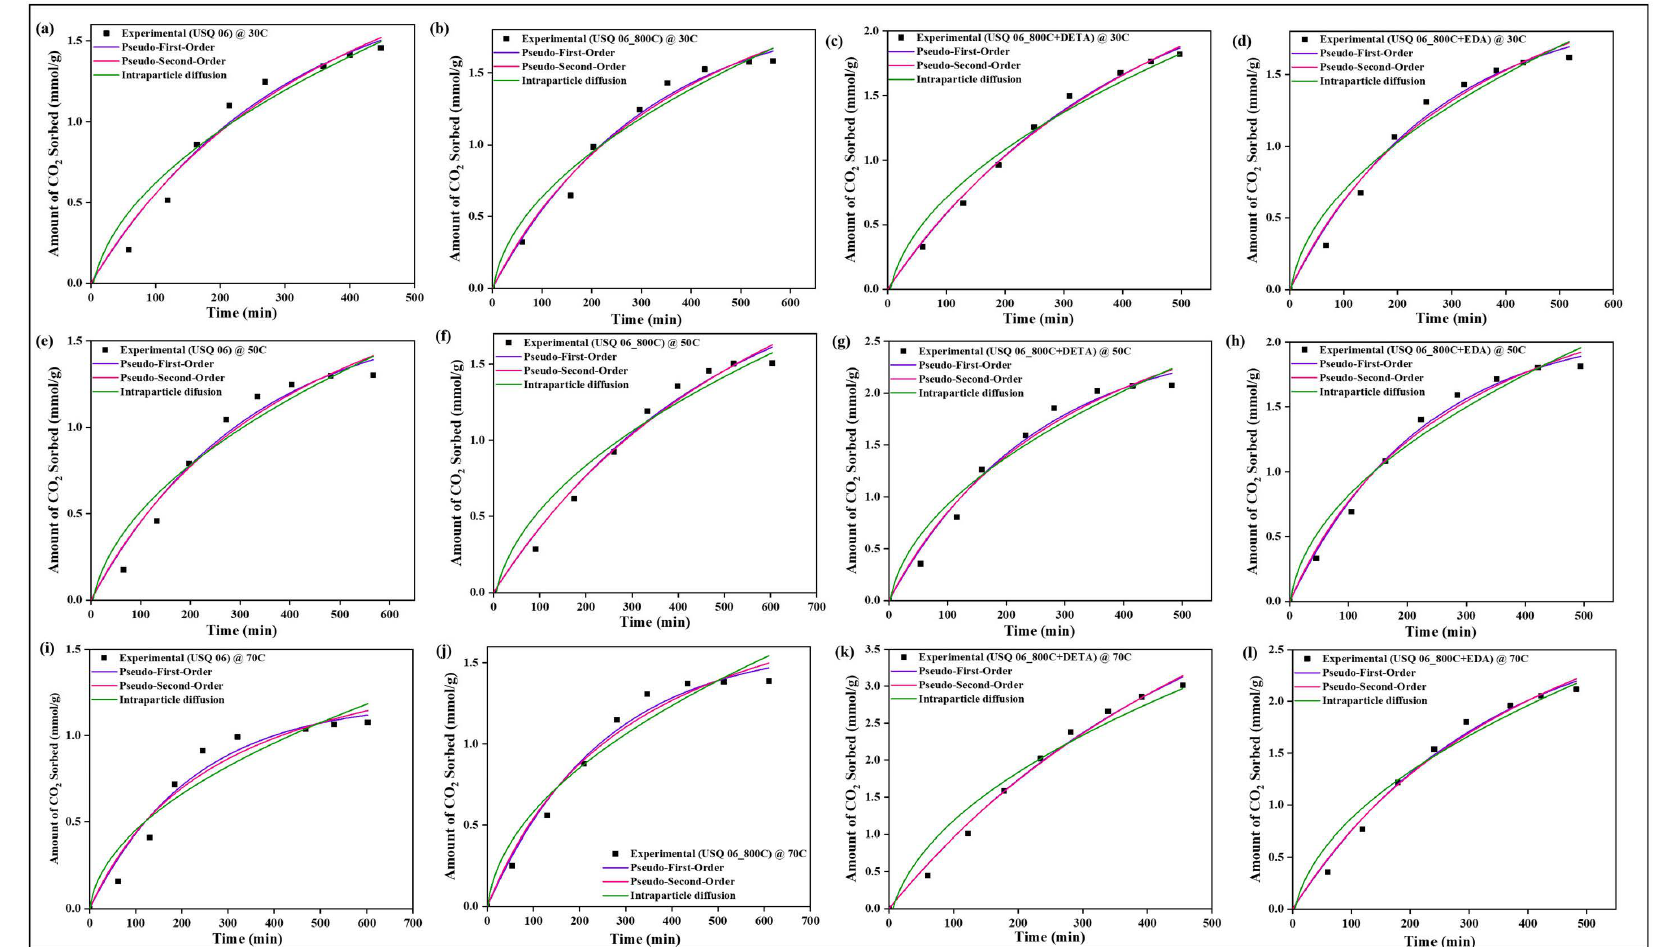
Figure 14. The prediction of sorption rate mechanism on USQ 06 variants at 30 ◦ C ( a – d ), 50 ◦ C ( e – h ), and 70 ◦ C ( i – l